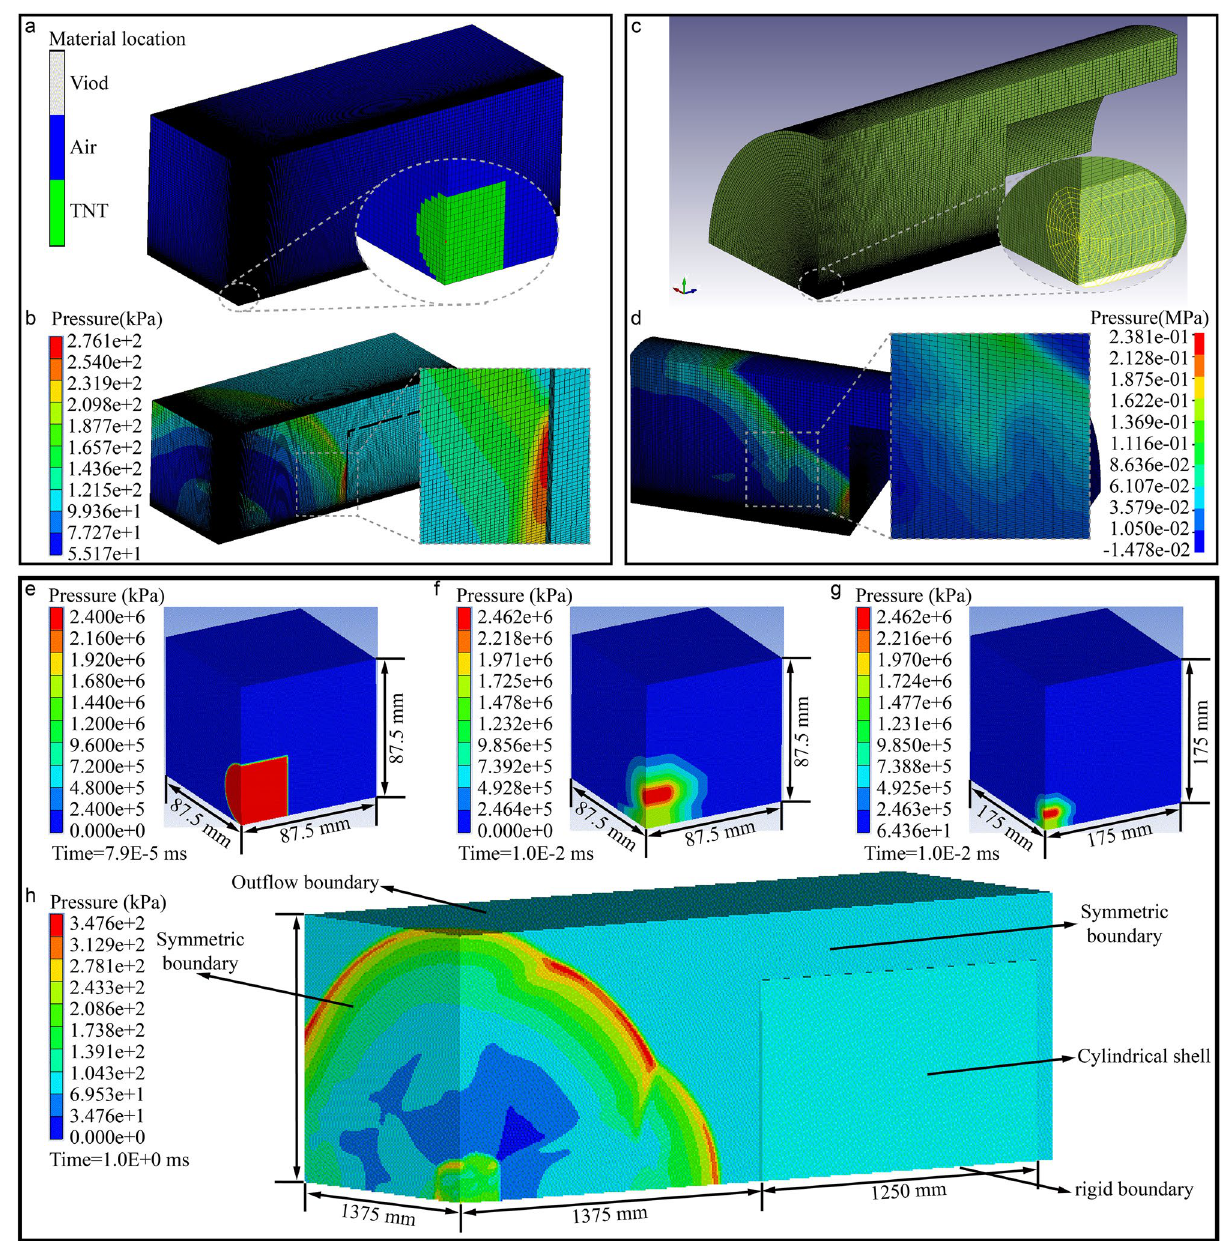
Figure 10. Gradient grid and block remapping. ( a,b ) Gradient grid model and simulation results in AUTODYN. ( c,d ) Gradient grid model and simulation results in LS-DYNA. ( e–h ) Block remapping process and simulation results in AUTODYN. ( e ) Initial pressure distribution. ( f ) Simulation results on 0.625 mm grids. ( g ) Block remapping to the model of 1.25 mm grids. ( h ) Final model after 5 consecutive block